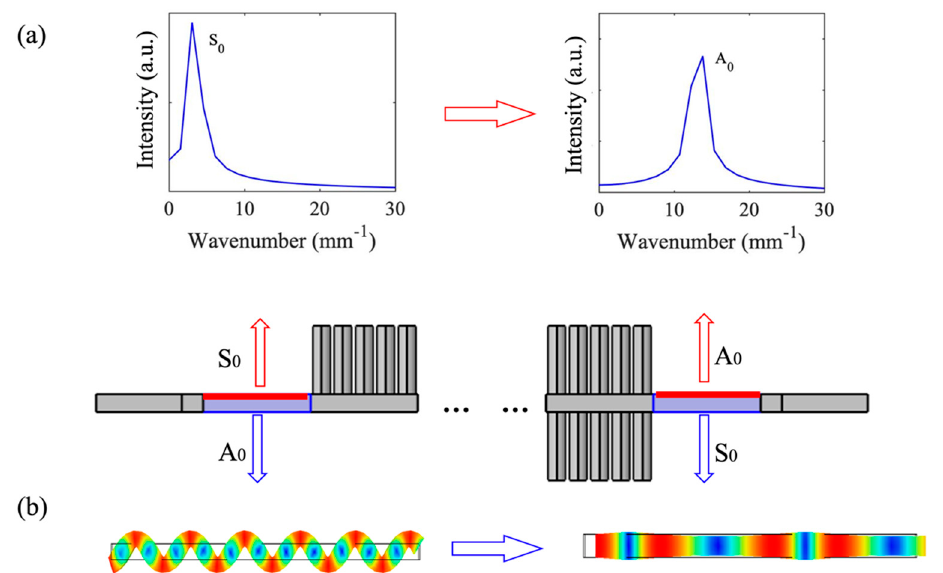
Figure 6. Conversion of the incident wave in forward transmission: ( a ) the excited S 0 Lamb mode is converted to the A 0 Lamb mode at 3 MHz by FFT; ( b ) the excited A 0 Lamb mode is converted to the S 0 Lamb mode at 5 MHz by the plate’s vibrations (side view of the plate).